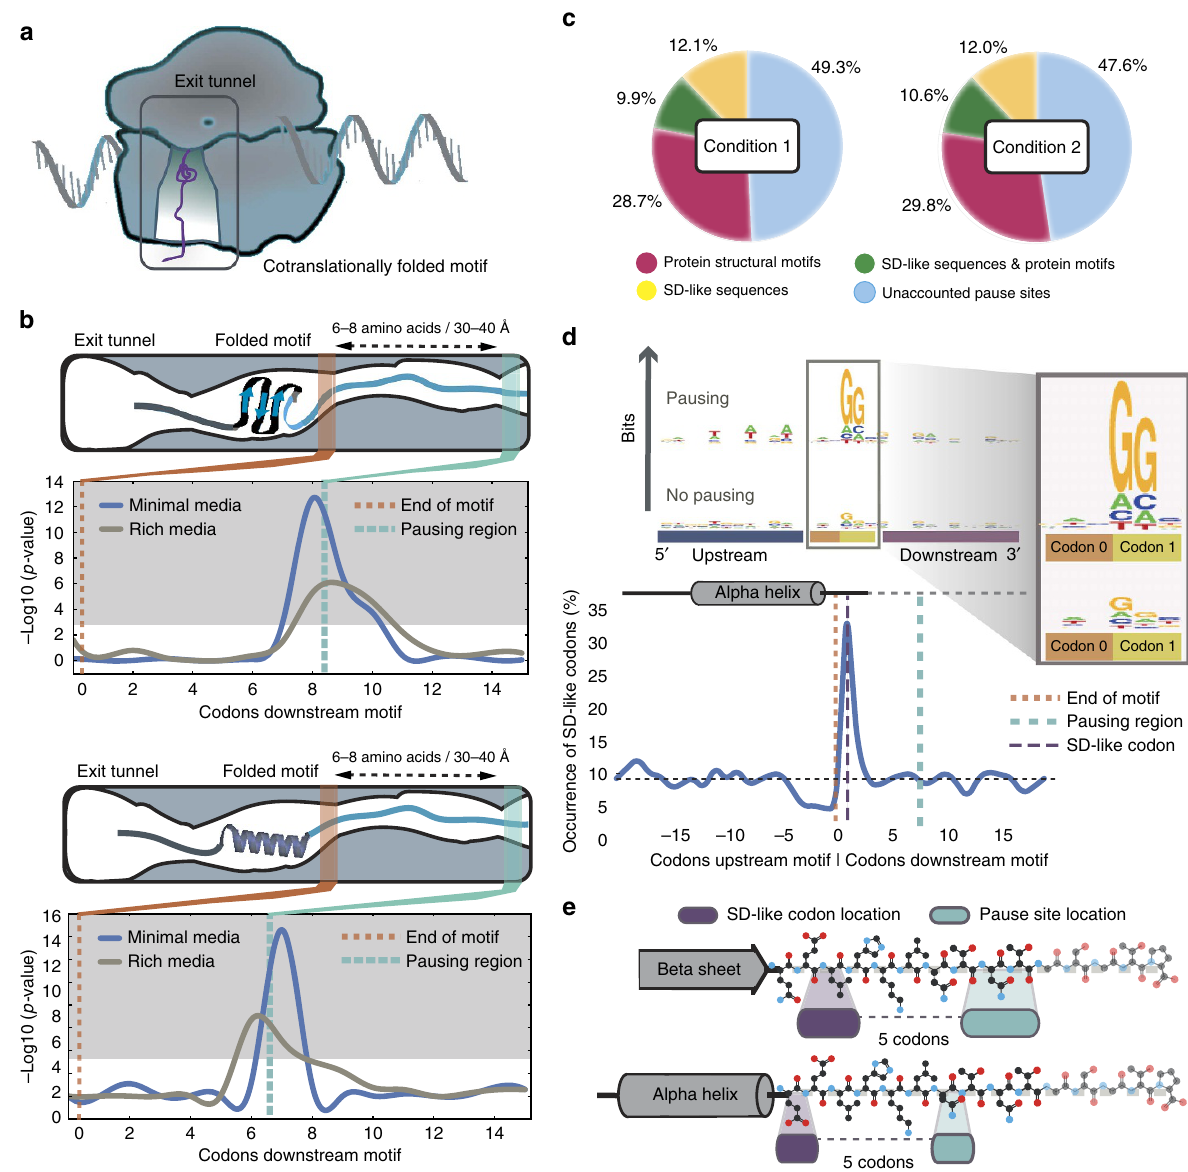
Figure 2 | Regularities in translational pausing and structural motifs. ( a ) Cartoon depiction of co-translational folding intermediates, such as secondary structure motifs, inside the ribosome exit tunnel. ( b ) Analysis of ribosome profiling and translational pausing in conjunction with protein structure properties in E. coli grown under MOPS Rich and MOPS Minimal media, taken from Li et. al. 11 . Pausing is enriched at positions downstream of protein secondary structures (top: b -sheets, bottom: a -helices, p -value o 6.67 (cid:2) 10 (cid:3) 3 ). These correlations are consistent across conditions (for example, minimal and rich nutrient conditions). ( c ) Coverage of specific secondary structure elements and sequence elements that account for increased ribosome occupancy. Condition 1 refers to minimal media and condition 2 refers to rich media. ( d ) Protein structure motifs that exhibit pausing have increased propensity for SD-like sequences compared with those which do not exhibit pausing or the global background existence, 35% SD-like codons for a -helices, 18% SD-like codons for b -sheets, compared with 9% global average. ( e ) A cartoon depiction of the relationship between structure, translation and